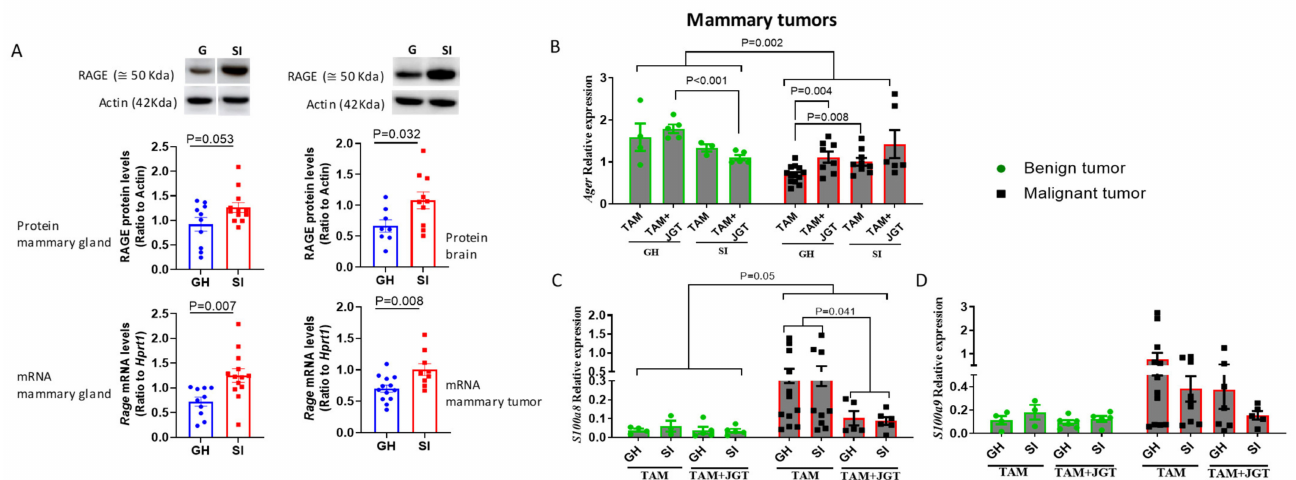
Figure 9. Effect of social isolation (SI) and Jaeumganghwa-tang (JGT) on the receptor for advanced glycation end-products (RAGE). ( A ) Protein and mRNA levels of RAGE/ Rage in the mammary glands, mammary tumors, and brains of group-housed (GH) and SI rats. The effect of JGT during tamoxifen (TAM) therapy on the gene expression of ( B ) Rage , ( C ) S100a8 , and ( D ) S100a9 in benign and malignant tumors of GH and SI rats. ( A ) SI increased mRNA expression of Rage in mammary glands and tumors and the RAGE protein levels in mammary glands and brain. ( B – D ) In benign tumors, JGT reduced the expression of Rage in SI rats compared with GH rats. In malignant tumors, JGT increased the expression of Rage in GH rats. Expression of Rage was significantly lower, and S100a8 and S100a9 was higher in malignant tumors compared with benign tumors. JGT treatment decreased the expression of S100a8 in both the GH and SI rats. Data were analyzed by ( A ) t -test, or ( B – D ) by 2-way and 3-way ANOVA followed by the Holm–Sidak test. Means ± SEM, n = 3–13 per group are